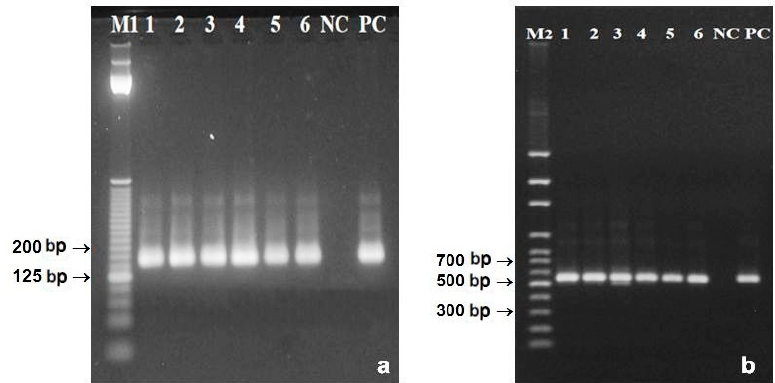
Figure 3. Amplification of 156 bp microsatellite psSSR69 ( a ) and 553 bp fragment of reference tubulin